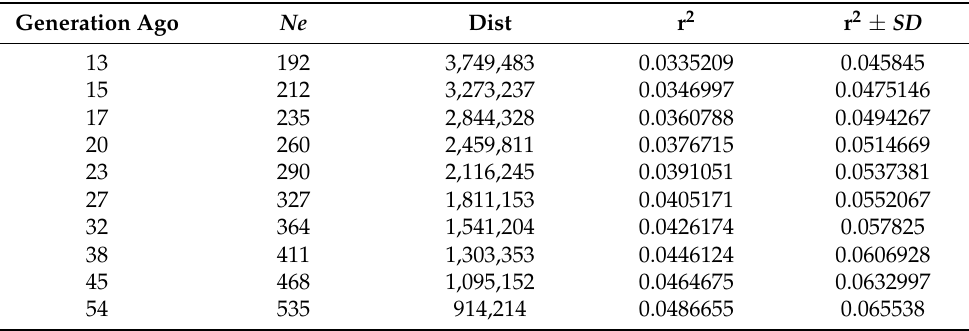
Table 3. Effective population size ( Ne ) within 54 generations of the Pelibuey